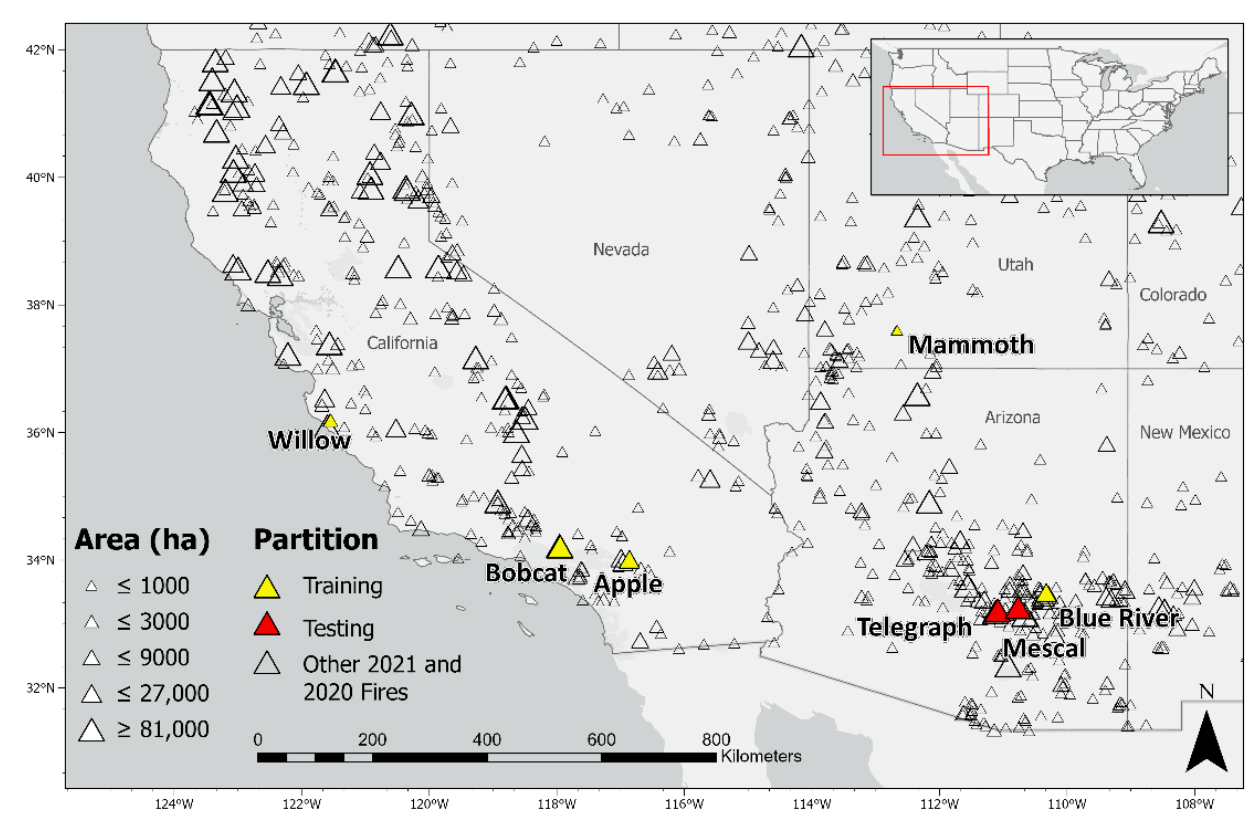
Figure 1. Study sites for the machine learning model (filled symbols) with all fires ≥ 40 ha in size from 2020 and 2021 (open symbols). The symbols are scaled to the final burn area. Table 1. Fire incident and imagery details. Scene ID ’s can be found in Supplemental Material www.mdpi.com/xxx/s1, Table S3: Scene